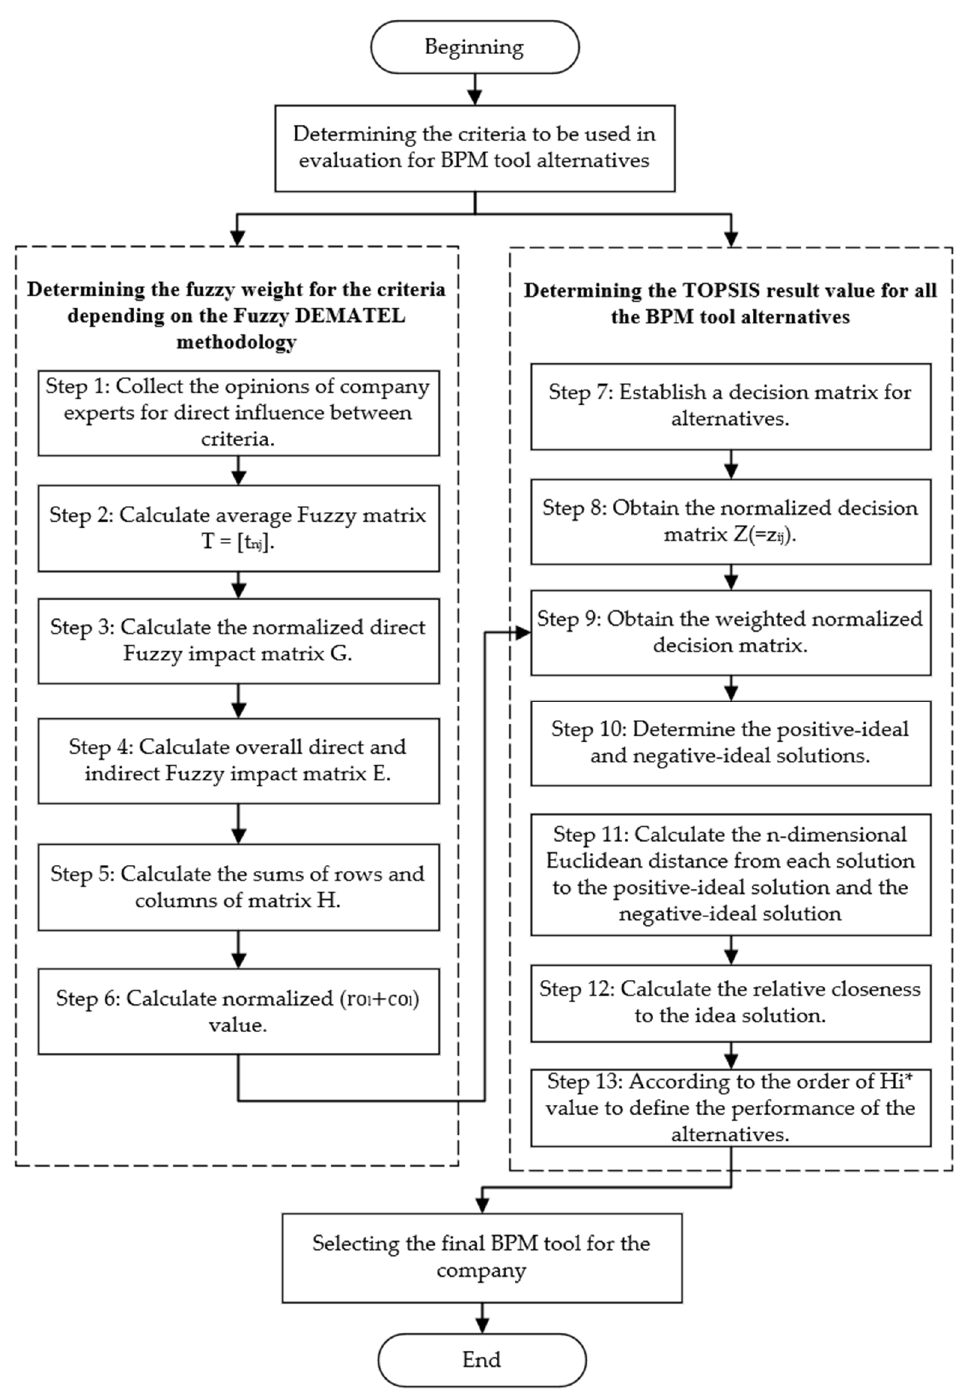
Figure 1. Whole process of the BPM tool selection method.